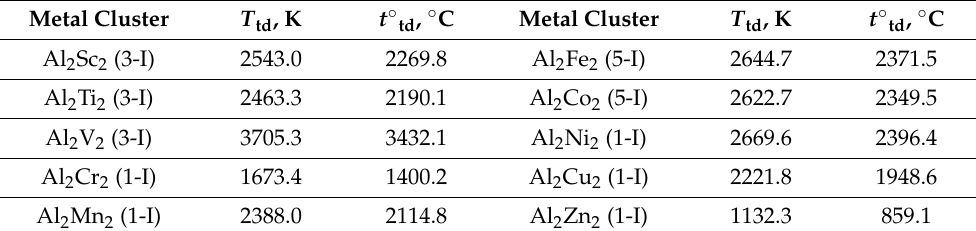
Table 7. Temperatures of the beginning thermal destruction ( T td , K) and ( t ◦ td , ◦ C) of the most energetically stable Al 2 M 2 metal